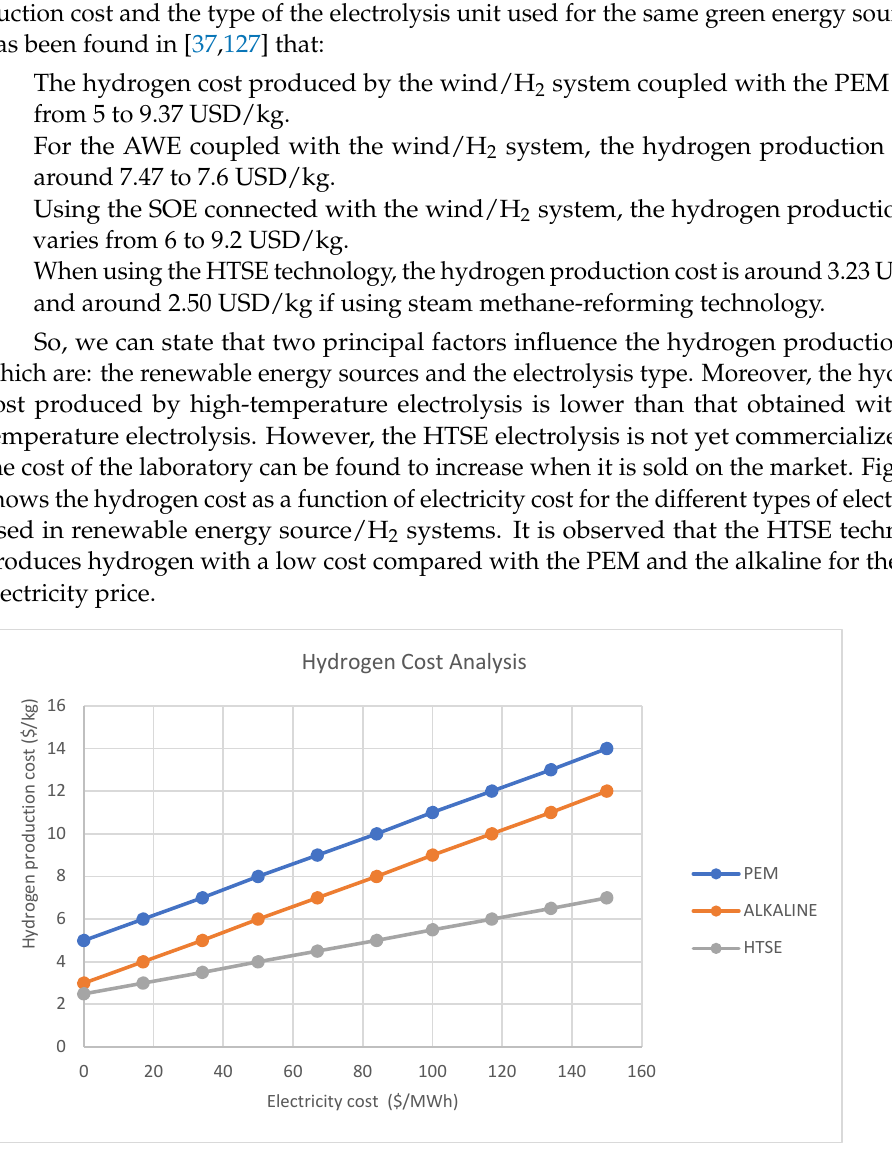
Figure 22. Hydrogen production cost versus electricity cost using different types of electrolysis units.